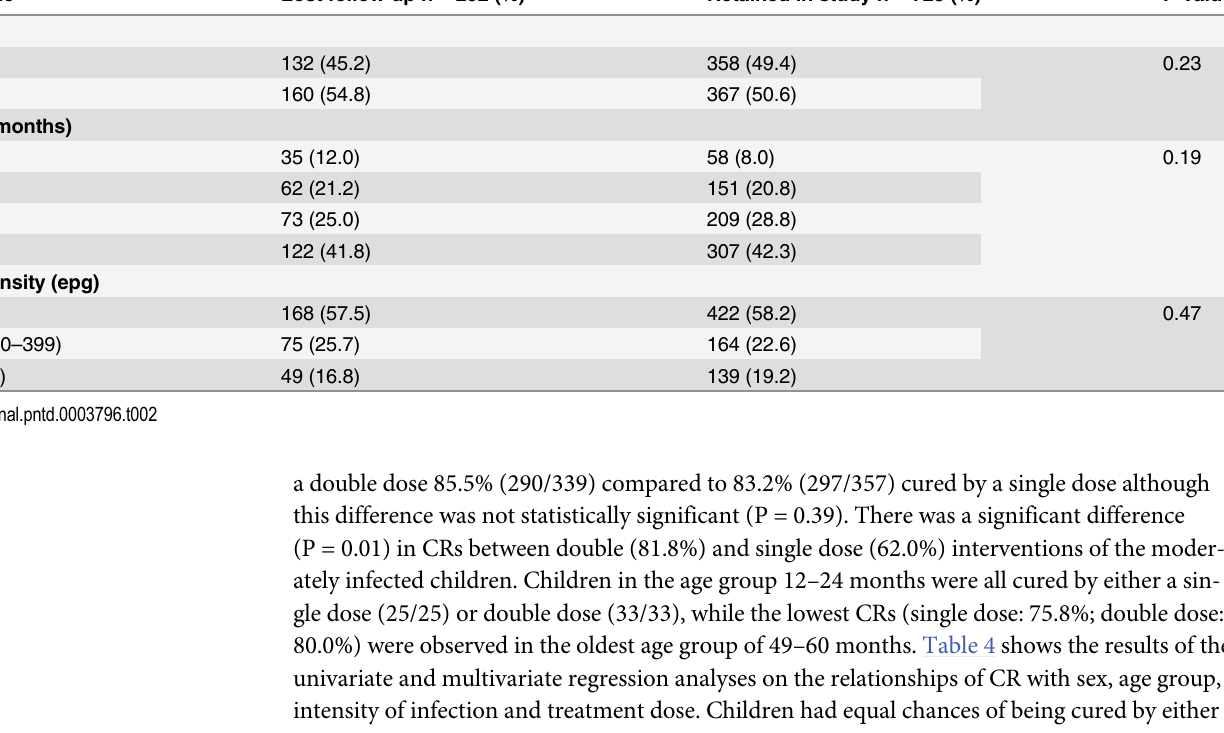
Table 2. Comparison of preschool-age children (n = 1017), who after randomization, were lost to follow-up or were retained in the study with regard to age, sex and infection intensity. Characteristic